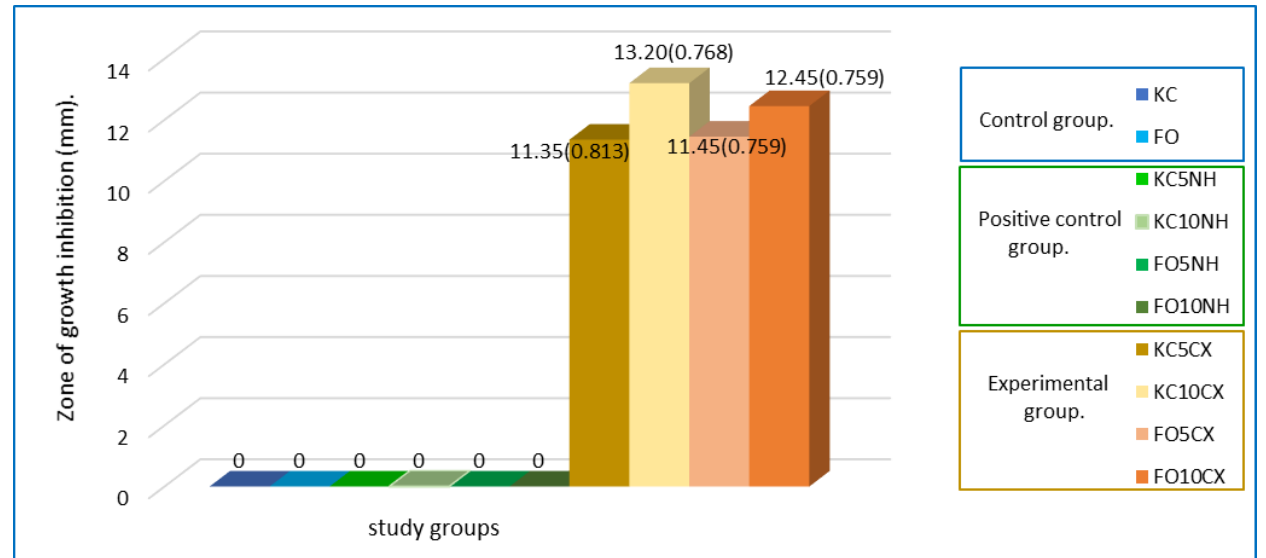
Figure 8. Inhibitory effect of the different groups analyzed in this study; mean (standard deviation); mm: millimeters.